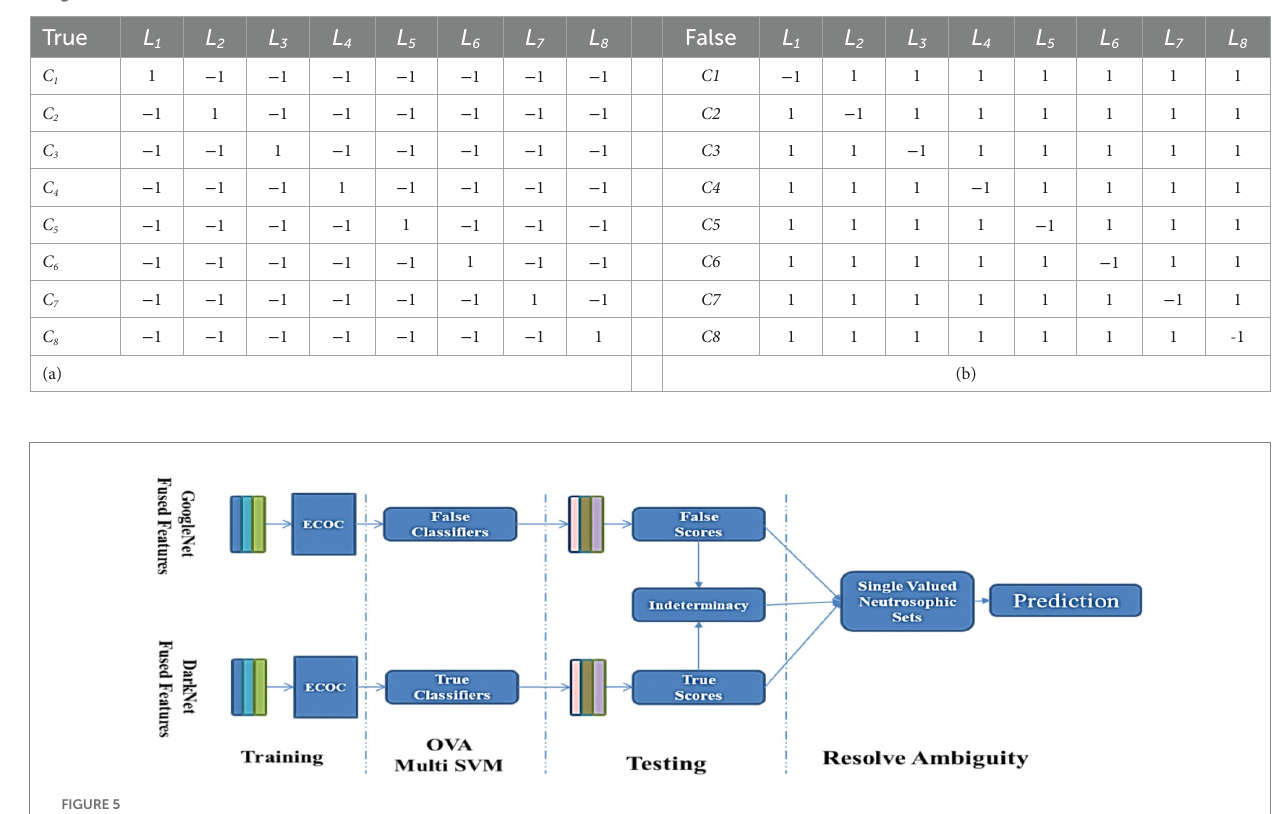
Algorithm 1, the conclusion of such classification is defined by SVNSs-TIF values, which are generated by the uncertainty border zone used to compute indeterminacy values (I).